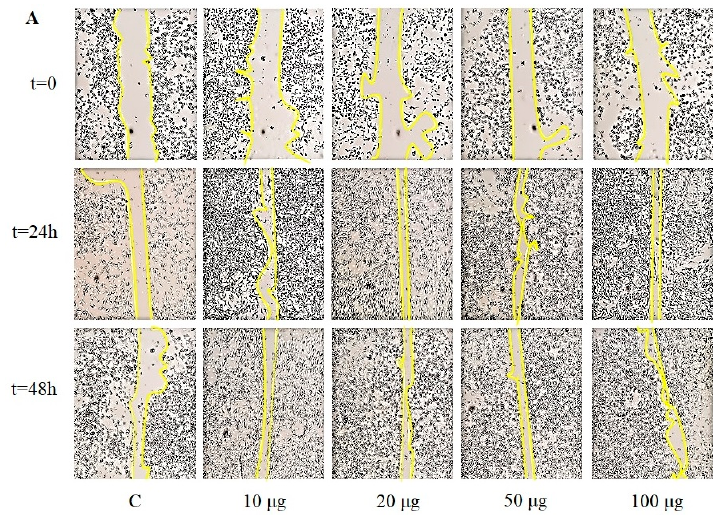
Figure 7. MTT assay of HaCat cells line treated with crude glucans ( A ) from SGJ1 (soluble glucans from jujubes of first harvesting); ( C ) SGJ2 (soluble glucans from jujubes of second harvesting); ( E )